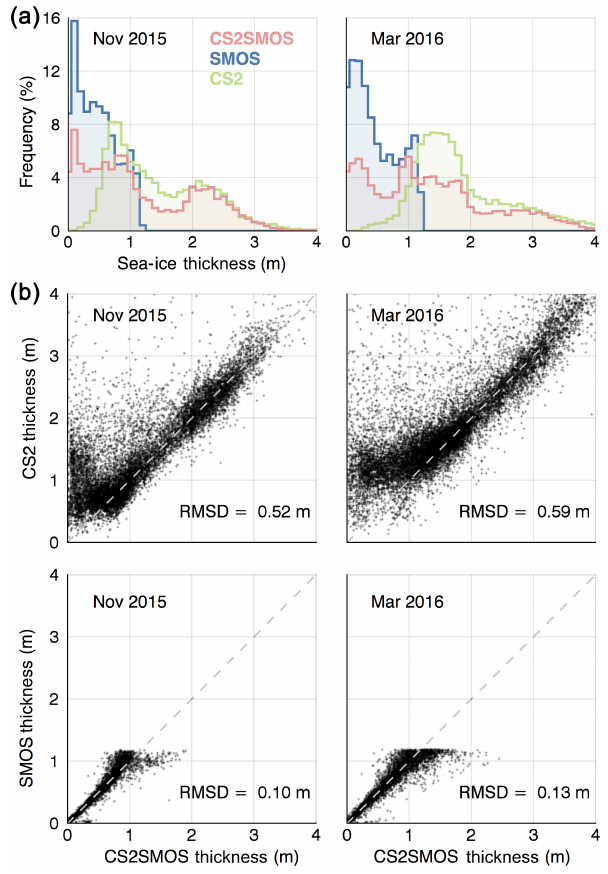
Figure 11. (a) Sea-ice thickness distributions of CryoSat-2, SMOS and CS2SMOS retrievals for November 2015 and March 2016. CS2SMOS is represented by 1 week in the middle of a month, while the CryoSat-2 and SMOS retrievals are monthly means. (b) Scatter diagrams illustrating the ice thickness differences be- tween CS2SMOS and the individual satellite retrievals of CS2 and SMOS, for November 2015 and March 2016.